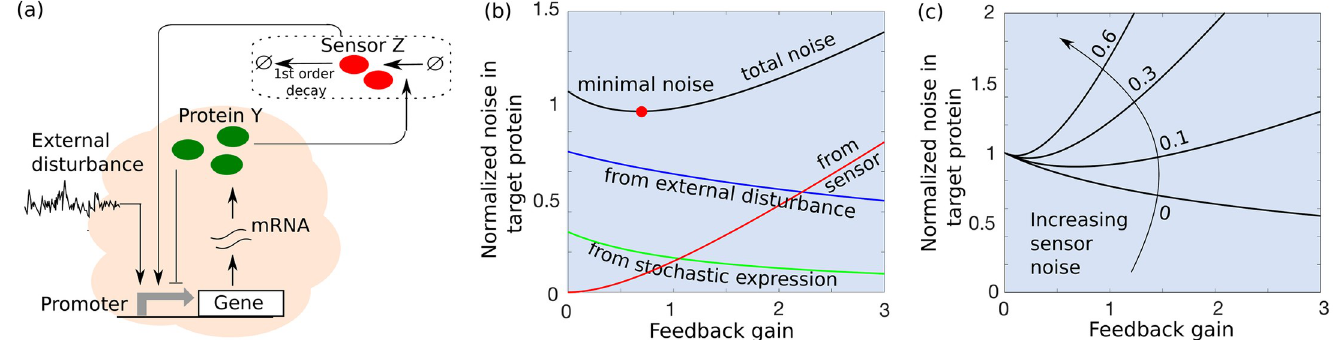
Fig 4. Implementation and noise decomposition for a derivative-based controller. (a) Schematic of the derivative controller where Y activates the sensor Z , Z activates the burst frequency of Y , while Y represses its own burst frequency (b) Different noise components in (57) are plotted as a function of the derivative feedback gain f d . Noise levels are normalized by the open-loop noise (17) and other parameters are chosen as CV 2 both the intrinsic noise, and the noise contribution from the external disturbance decrease with increasing f contrast to the proportional feedback, the intrinsic noise decreases faster than the disturbance contribution. (c) The noise in Y as a function of the derivative feedback emphasizes the nonmonotonic noise profile for different levels of sensor noise CV 2 gain f d